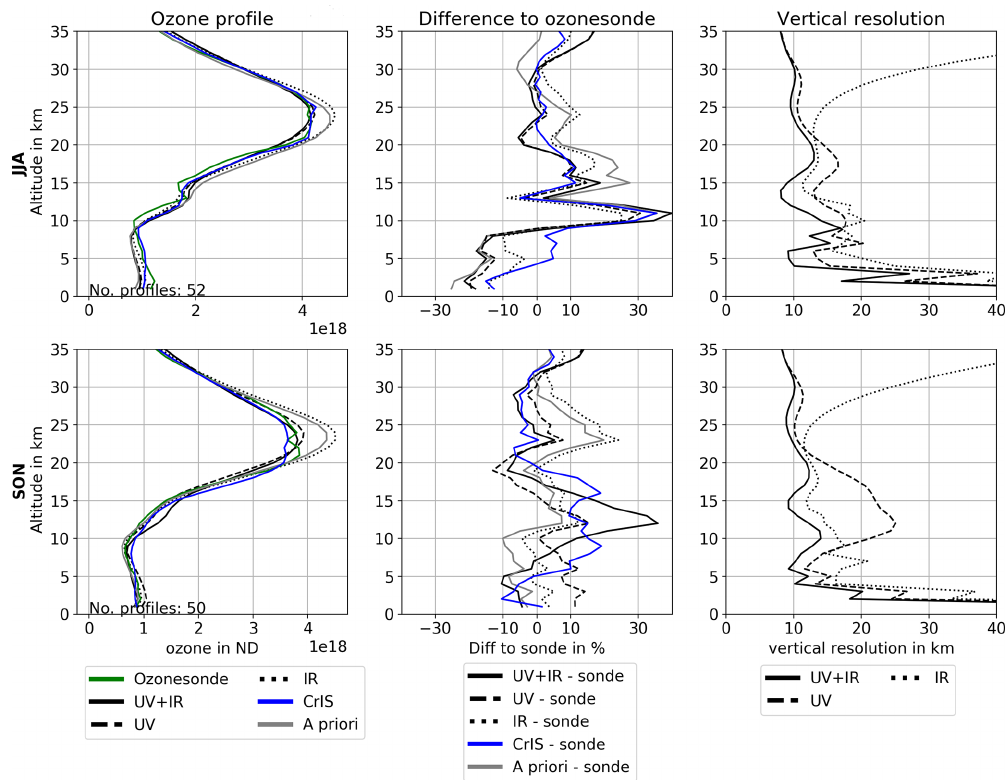
Figure 9. Ozone profile comparisons using ozonesondes and NASA operational CrIS profiles at northern latitudes (20–60 ◦ N) separated into summer (JJA) and autumn (SON)